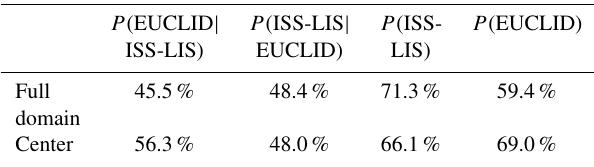
Figure 6. Estimated peak currents of matched EUCLID CG strokes (solid) and IC pulses (dashed) are correlated with the corresponding ISS-LIS group radiance. In general, higher peak current signals are correlated with higher ISS-LIS radiances. In addition, the CG and IC sample size is indicated in gray. Table 2. Relative and absolute flash detection efficiencies for EU- CLID and the